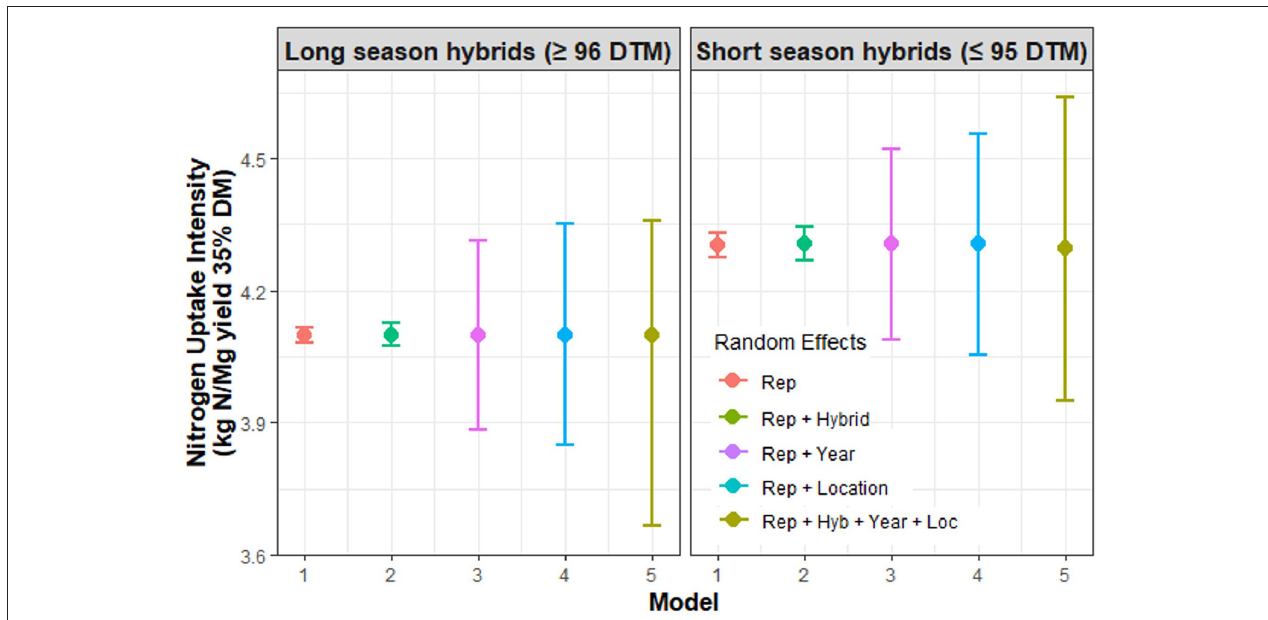
FIGURE 2 | Four linear mixed effect models were fitted to compare the influences of silage hybrid selection (“hybrid”), farm management strategies (“location”), and growing season (“year”) on nitrogen uptake intensity (N uptake per unit of yield). Models were evaluated on data clustered by relative maturity classification (short- vs. long-season